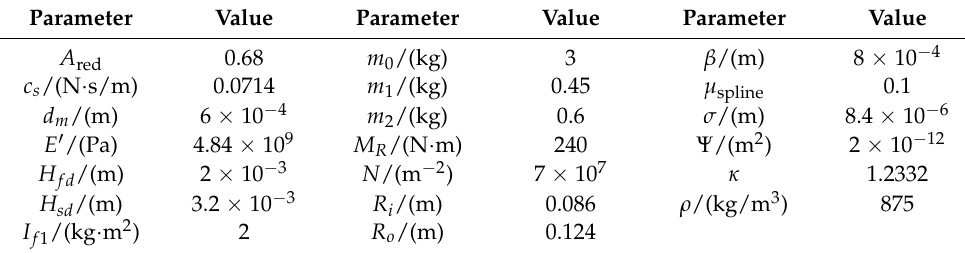
Table 1. Input data of the simulation.